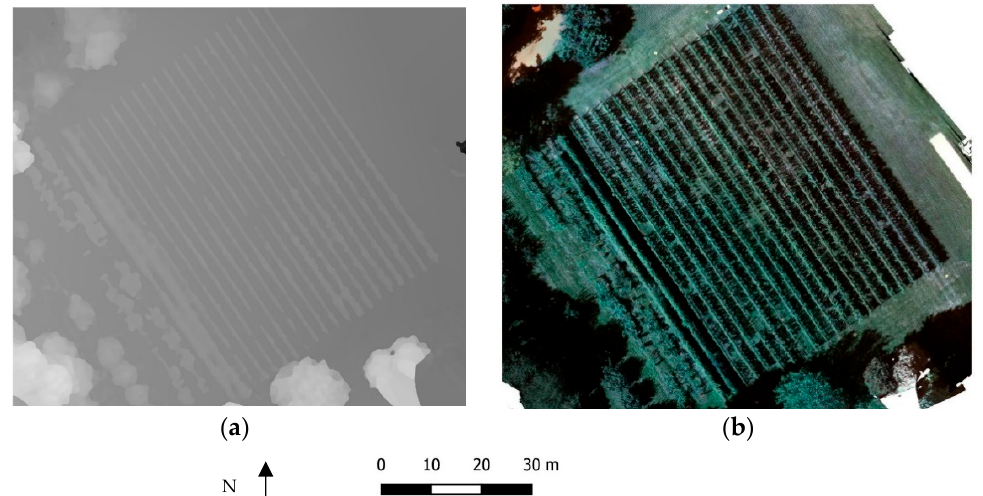
Figure 7. ( a ) Digital Elevation Model (DEM), and ( b ) RGB orthophoto obtained by combining Red W, Green and Blue orthophotos.